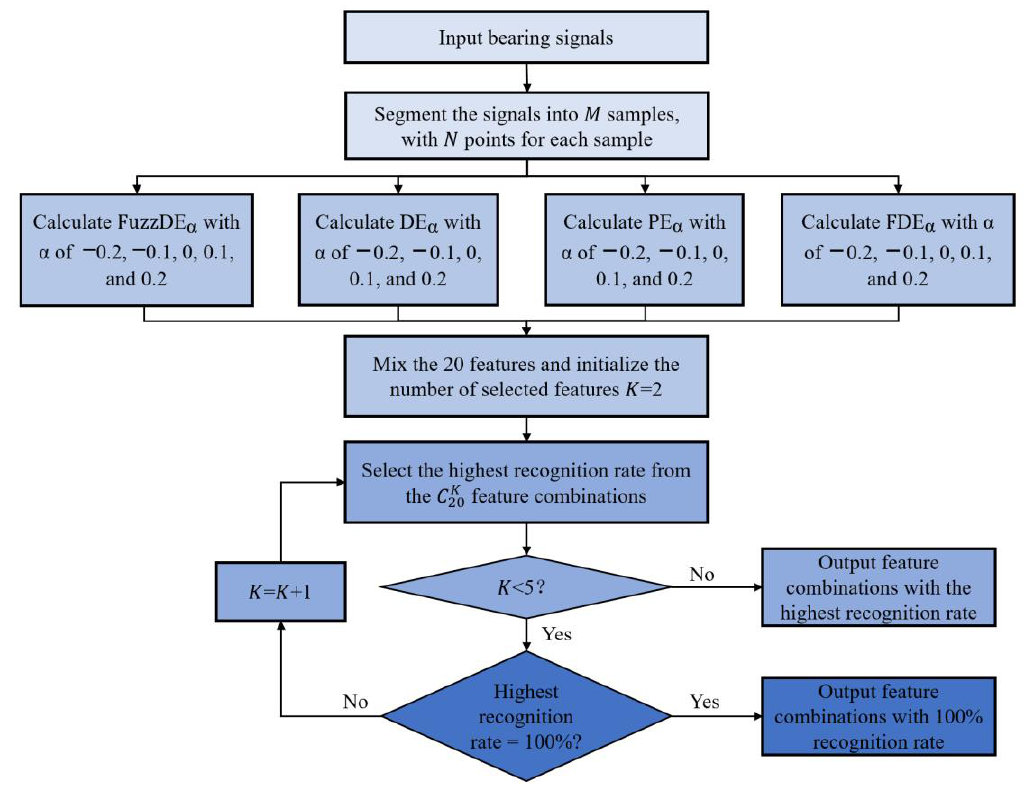
Figure 8. Flow chart of the proposed mixed features bearing fault diagnosis method.